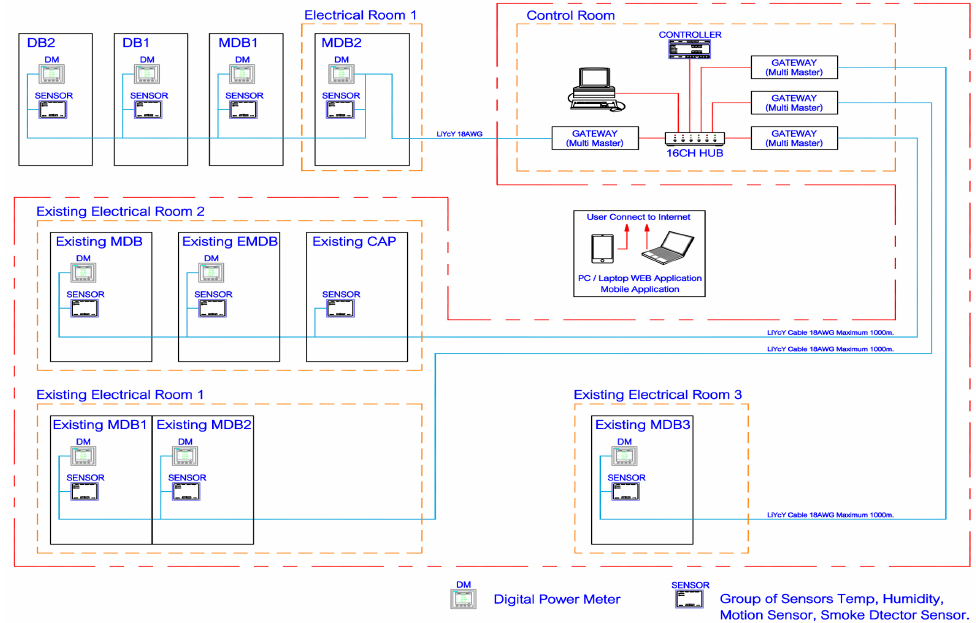
Figure 4. Display of the intranet sensors system architecture and installation in an electrical structure.